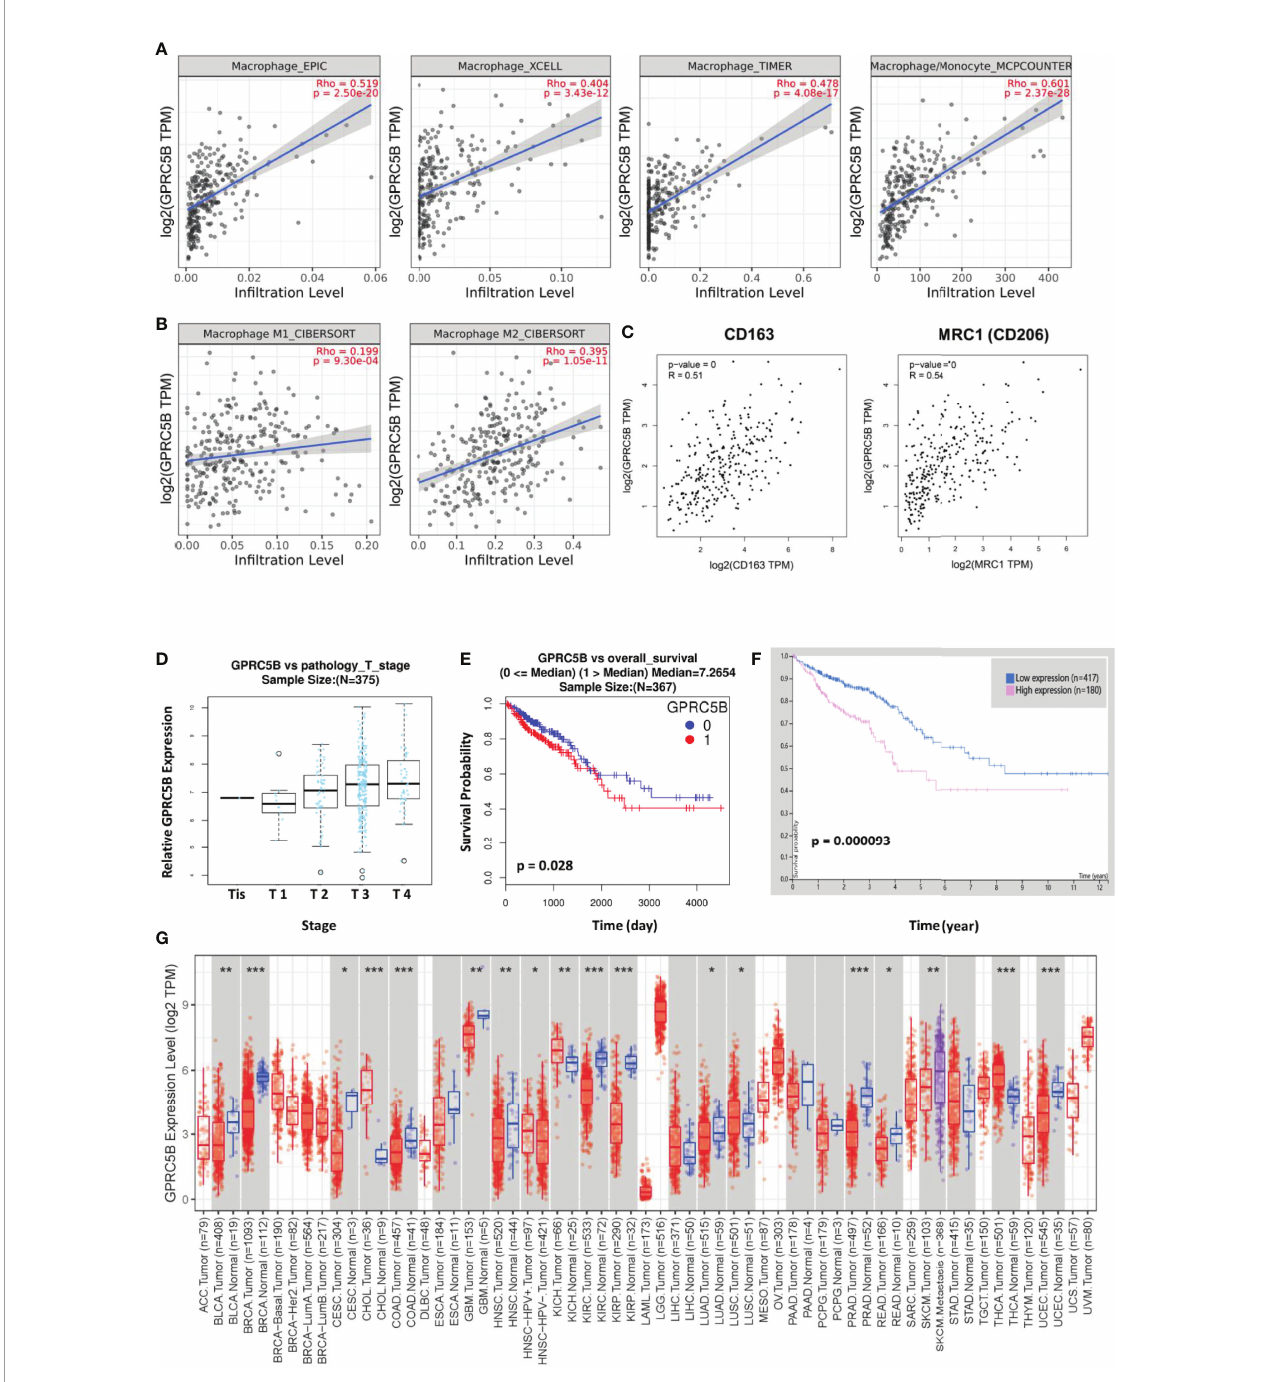
FIGURE 8 | (A) Based on the EPIC, XCELL, TIMER, and MCPcounter algorithms, GPRC5B was closely correlated with tumor-in fi ltrating macrophages in COAD. (B) The CIBERSORT algorithm indicated a closer correlation between GPRC5B and M2 macrophages (r = 0.395, p < 0.01), compared with M1 macrophages (r = 0.199, p < 0.01). (C) The GEPIA database showed that GPRC5B was signi fi cantly correlated with the M2 macrophage surface marker CD163 (r = 0.51, p < 0.01) and MRC1 (r = 0.54, p < 0.01). (D) The LinkedOmics database con fi rmed that GPRC5B was gradually upregulated following the progress of COAD development through different tumor stages. (E) The LinkedOmics database indicated that GPRC5B could be a potential risk factor for COAD (p < 0.05). (F) The Human Protein Atlas database indicated that GPRC5B could be a potential risk factor for COAD (p < 0.05). (G) The Timer 2.0 database showed the mRNA expression level of GPRC5B across various tumor types. GPRC5B was signi fi cantly downregulated in COAD samples (p < 0.001). GPRC5B, G protein-coupled receptor class C group 5 member B; COAD, colon adenocarcinoma; TPM, Transcripts per million. * p ≤ 0.05; ** p < 0.01; *** p <